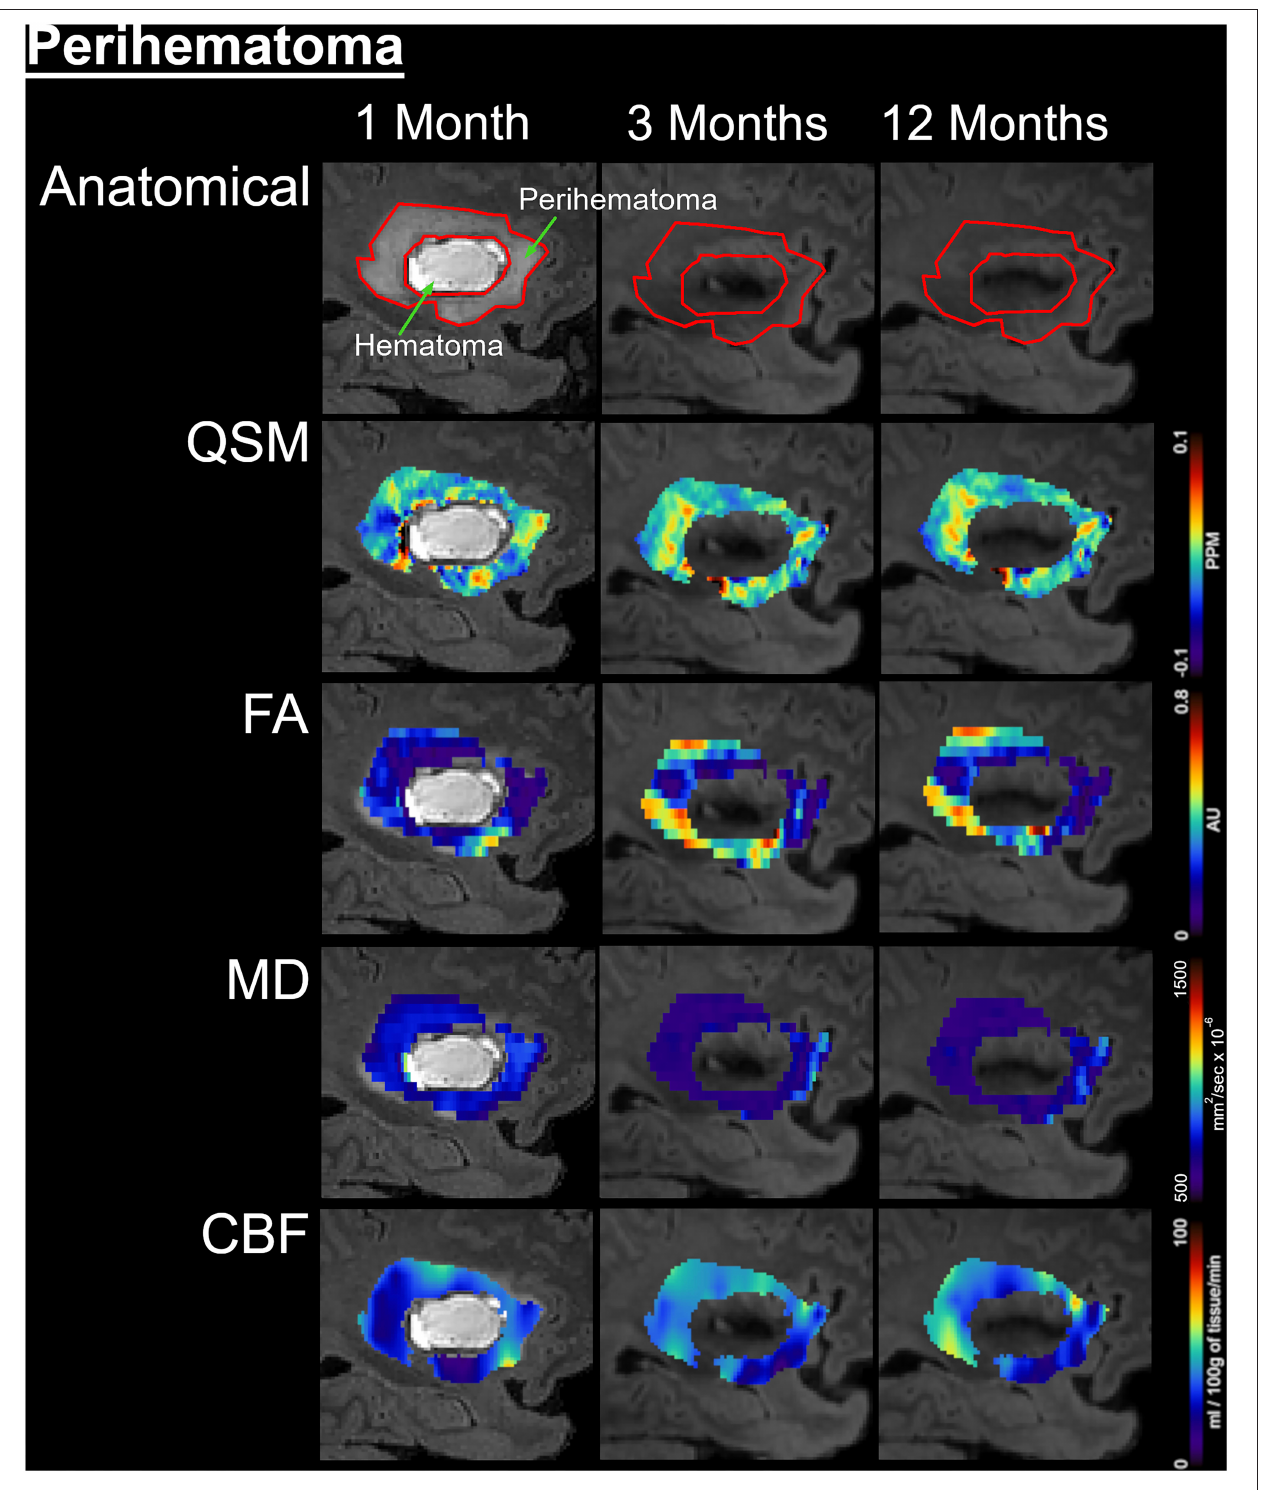
FIGURE 3 | Temporal changes in the perihematomal tissues are shown on a fluid-attenuated inversion recovery (FLAIR) by color-coded voxel by voxel quantitative maps in a represented patient. The rows are illustrating the imaging measurements whereas columns are showing changes at 1, 3, and 12 months of onset. In the top row, the first image outlined the perihematomal and hematoma regions that were used as regions-of-interest (ROI) to measure imaging matrices over time. The rows 2–5 are displaying quantitative susceptibilities maps (QSM), fractional anisotropy (FA), mean diffusivity (MD), and cerebral blood flow (CBF) in the perihematomal tissues overtime,